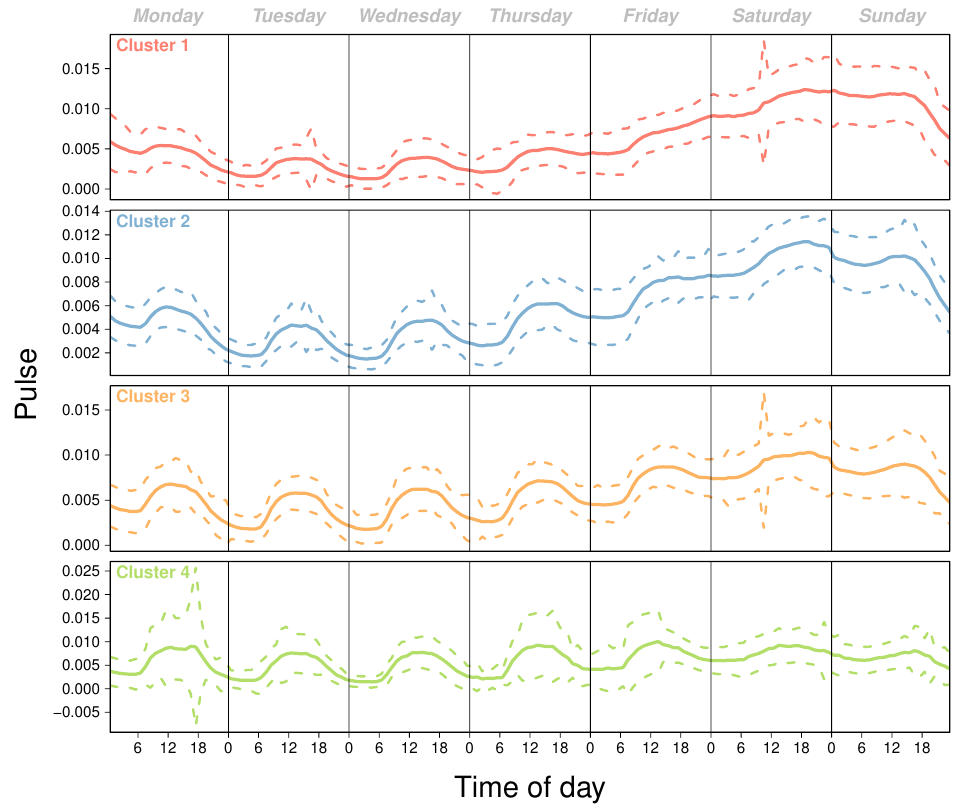
Figure A7. Pulses associated with the four main clusters. The solid lines represent the average pulse, while the dashed lines represent one standard deviation.